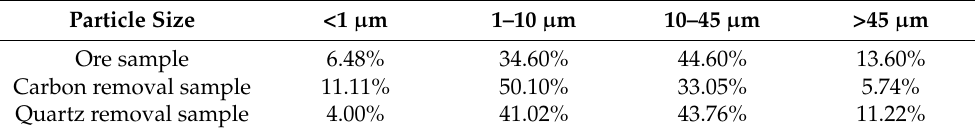
Table 2. Particle size distributions of ore, carbon-free, and quartz-free